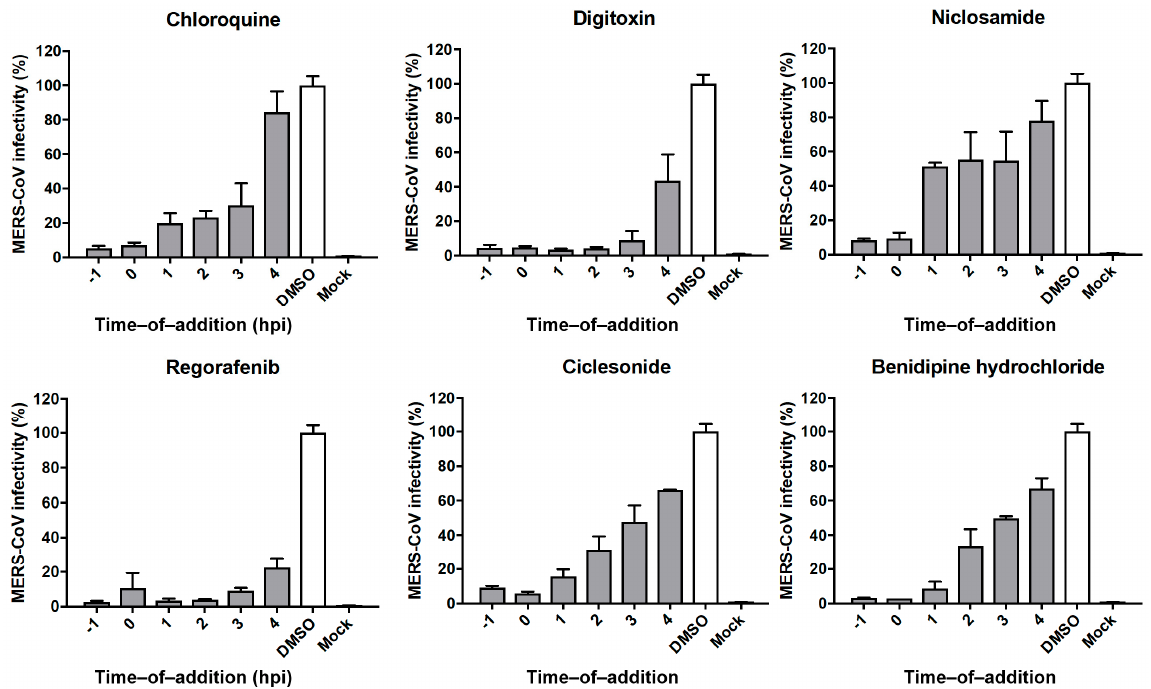
Figure 2. Time-of-addition study with selected FDA-approved drugs. Five FDA-approved drugs were analyzed by time- course experiments to determine the stage of the MERS-CoV life cycle inhibited. Vero cells were infected with MERS-CoV at a multiplicity of infection of 5, and FDA-approved drugs were administered at six time points pre- or post-infection as indicated. Drugs were used at concentrations above their 90% inhibitory concentration (IC 90 ) values. Chloroquine served as a known early stage inhibitor.